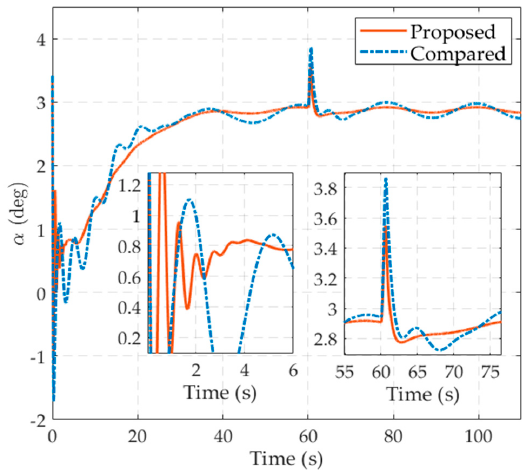
α Figure 5. The curves of angle of attack α in the comparative Figure 5. The curves of angle of attack in the comparative simulations. Figure 5. The curves of angle of attack  in the comparative simulations.